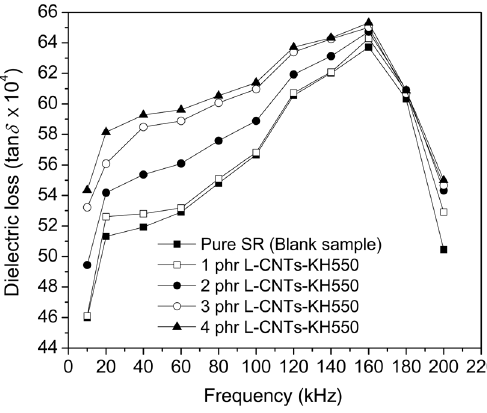
Figure 9 Dielectric loss of L-CNT-KH550/SE composites with differ- ent frequencies of outer electric